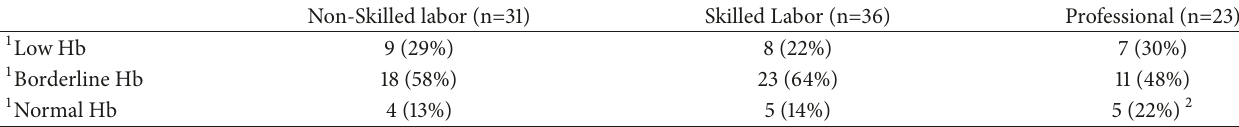
Table 2: Hemoglobin levels and occupation of the head of household.